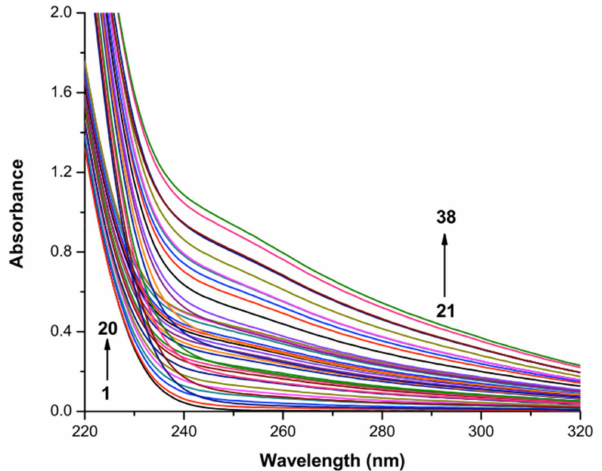
Figure 2. Absorption spectra of manganese(II)-1,3-diaminopropane complexes in methanol solution. For spectra 1 to 20, [Mn(II)] = 0.144 mM and 1,3-diaminopropane concentration (mM): (1) 0.0144; (2) 0.0288; (3) 0.0432; (4) 0.0576; (5) 0.072; (6) 0.0864; (7) 0.1008; (8) 0.1152; (9) 0.1296; (10) 0.144; (11) 0.1584; (12) 0.1728; (13) 0.1872; (14) 0.2016; (15) 0.216; (16) 0.2304; (17) 0.2448; (18) 0.2592; (19) 0.2736; (20) 0.288. For spectra 20 to 40, [Mn(II)] = 0.288 mM and 1,3-propanediamine concentra- tion from (mM): (21) 0.0288; (22) 0.0576; (23) 0.0864; (24) 0.1152; (25) 0.144; (26) 0.1728; (27) 0.2016; (28) 0.2304; (29) 0.2592; (30) 0.288; (31) 0.3168; (32) 0.3456; (33) 0.3744; (34) 0.4032; (35) 0.432; (36) 0.4608; (37) 0.4896; (38) 0.5184; (39) 0.5472; (40) 0.576.